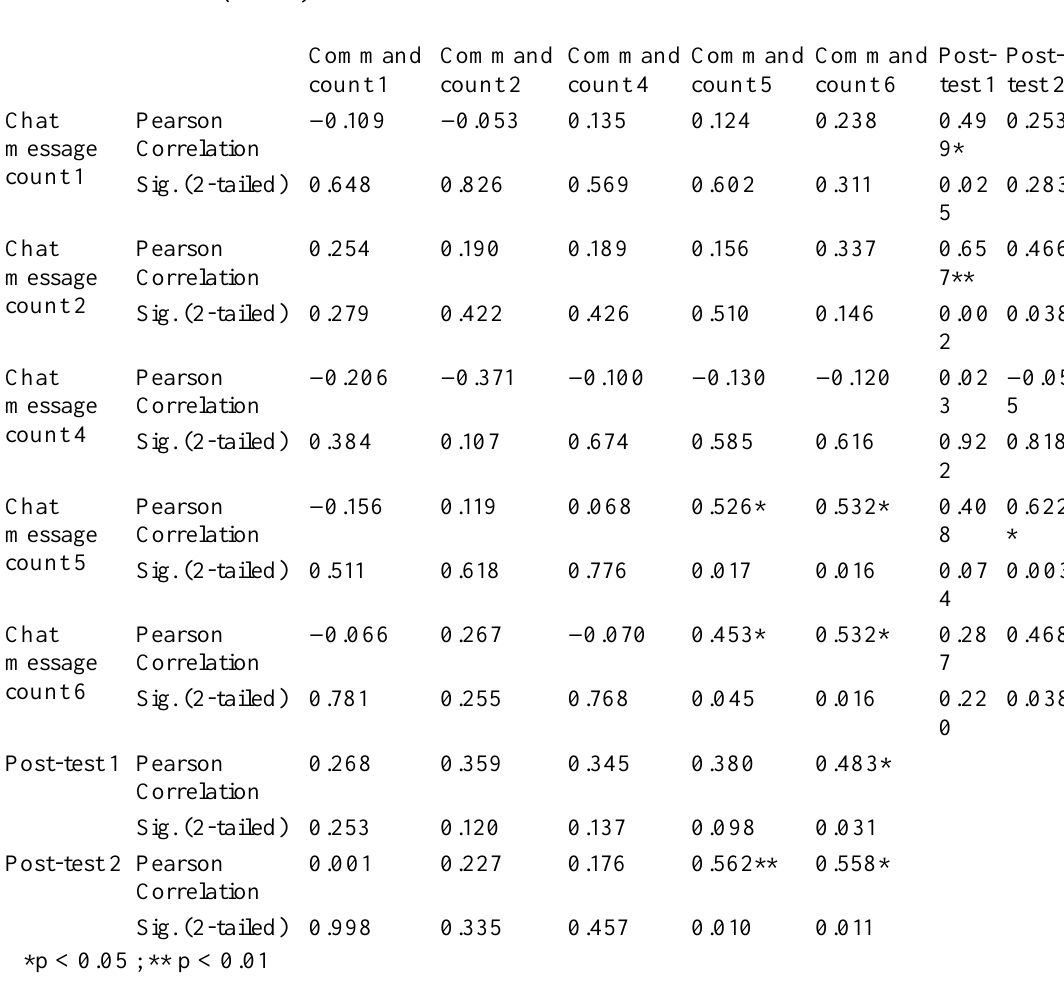
Pearson Correlation Result Between the Post-Test, the Chat Message Count, and the Command Count (n =